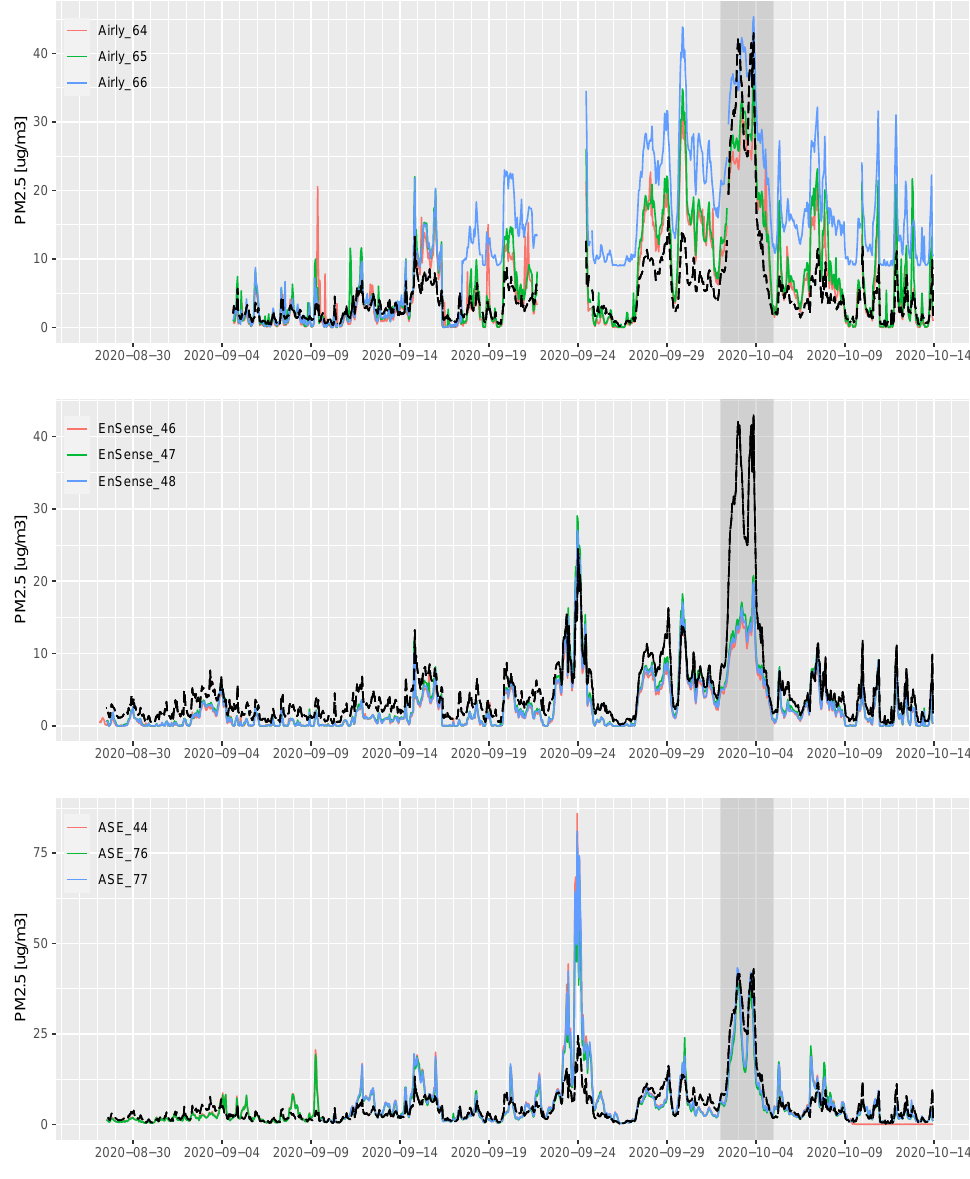
Figure 3. Time series of the factory-calibrated PM 2.5 signal of all sensors systems. The dashed black line shows the reference data from the Fidas. The top panel shows the three Airly sensors, the center panel the three EnSense sensors, and the lower panel the three AirSensEUR (ASE) sensors. Note that the y-axis range varies from panel to panel for clarity. The dark gray box indicates an episode of long-range